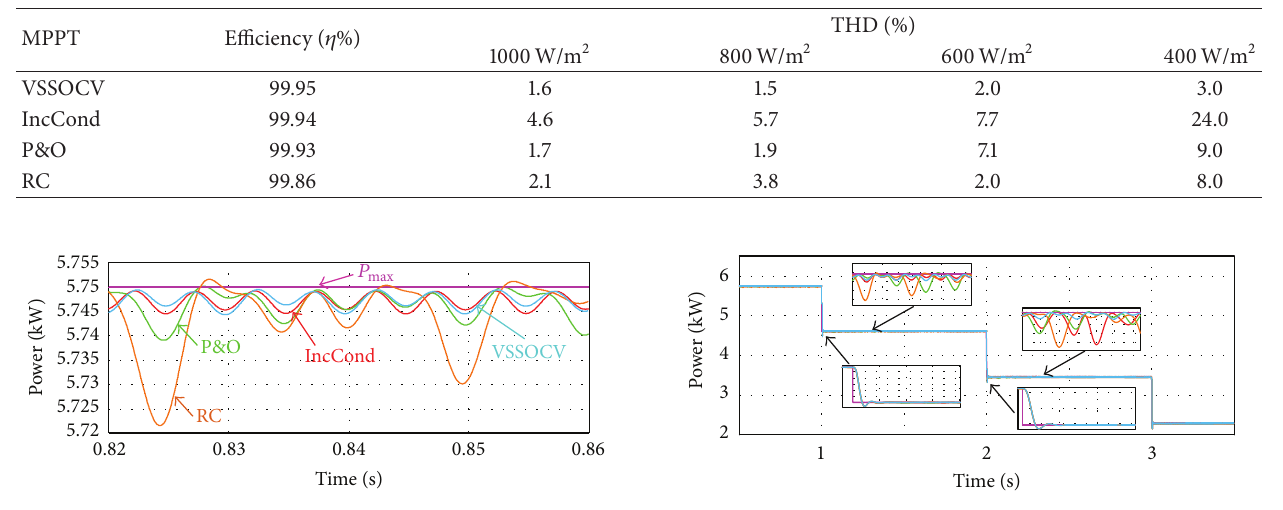
Figure 10: Power extracted from PV panels in steady state at 1000 W/m 2 .